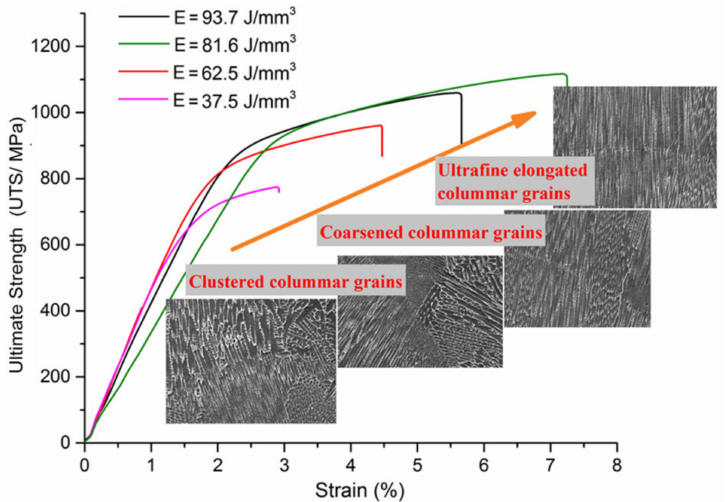
Figure 9. The relationship between microstructures and mechanical properties under different energy